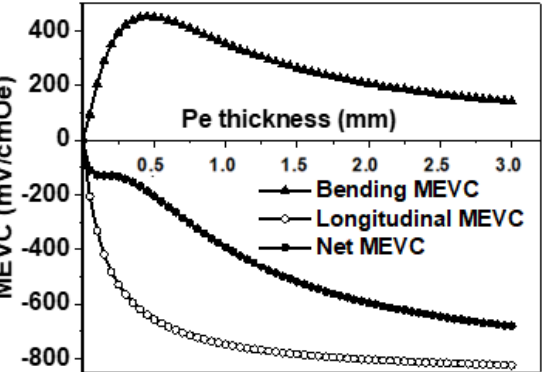
Figure 4. Results on estimated MEVC vs. t m , as in Figure 2 for a bilayer of Permendur (Pe) and PZT for t p = 0.5 mm.